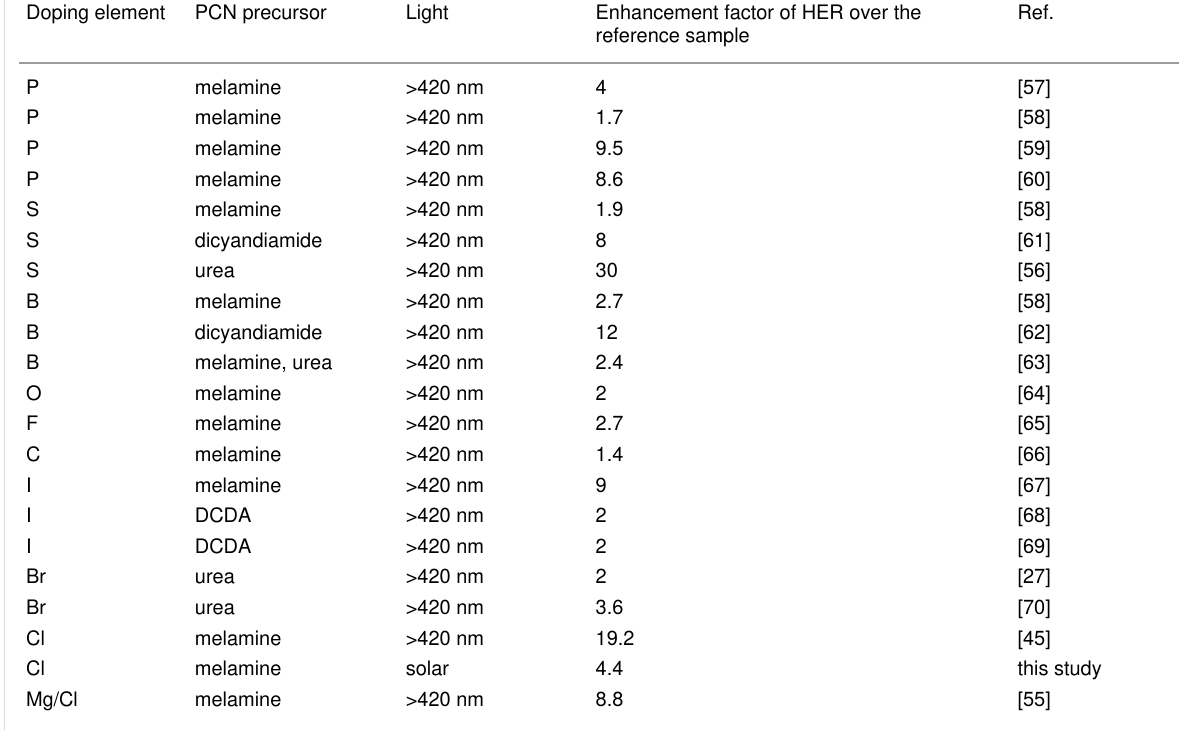
Table 4: Comparative study of the photocatalytic hydrogen evolution of Cl- PCN and other carbon nitride catalysts doped with other elements. Doping